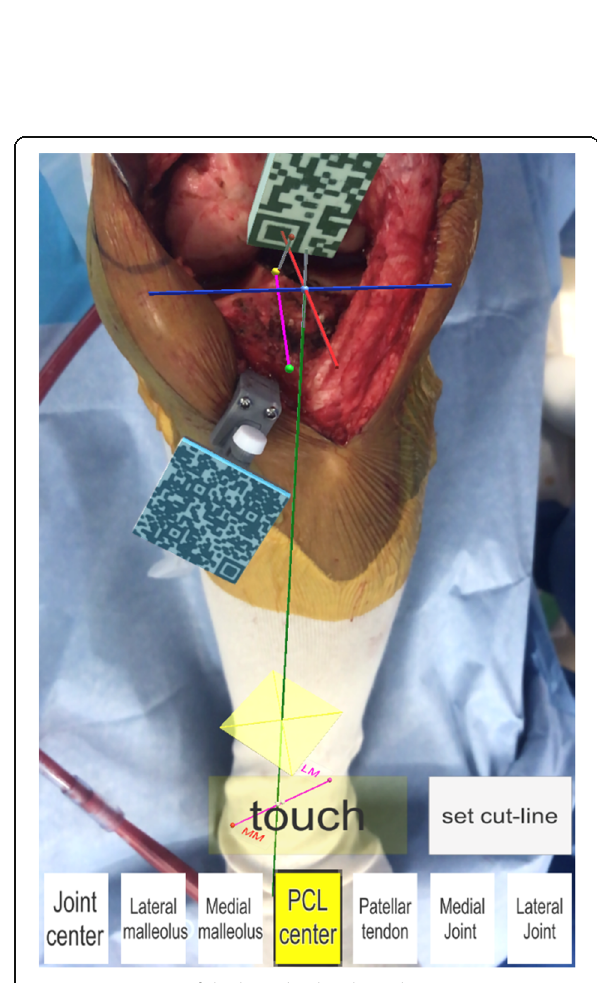
Fig. 3 Registration of the bone landmarks in the AR-KNEE system. The surgeon registered bone landmarks using the pointer (the pin attached to the resin marker with rectangular two-dimensional bar code). The AR-KNEE system visualized the tibial long and the anteroposterior axes as green and pink lines, respectively